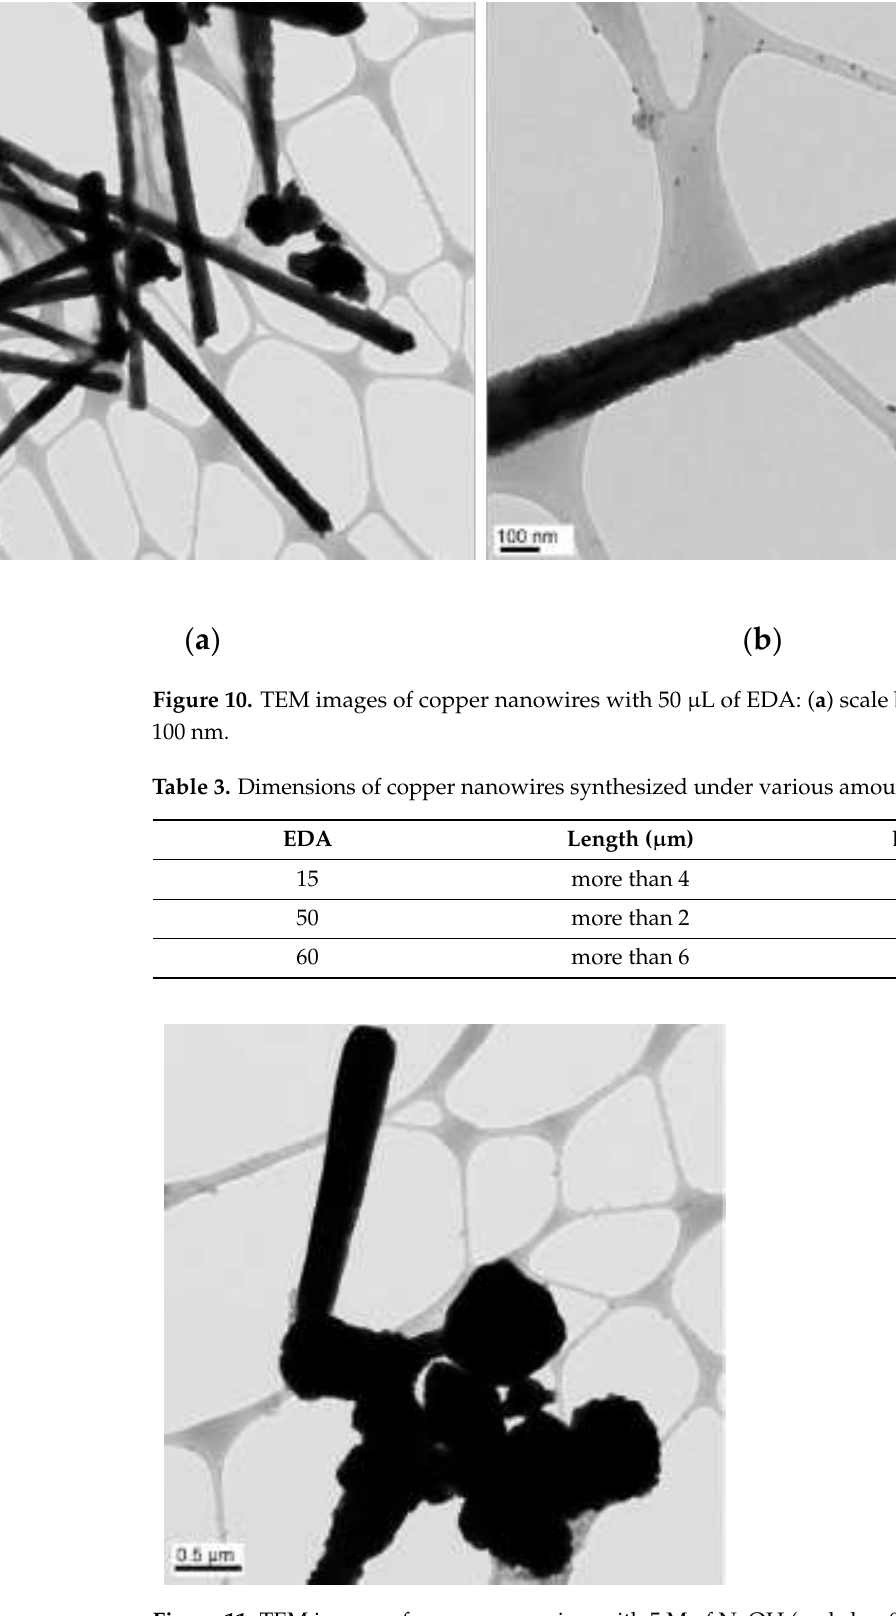
Figure 11. TEM images of copper nanowires with 5 M of NaOH (scale bar 0.5 µm).